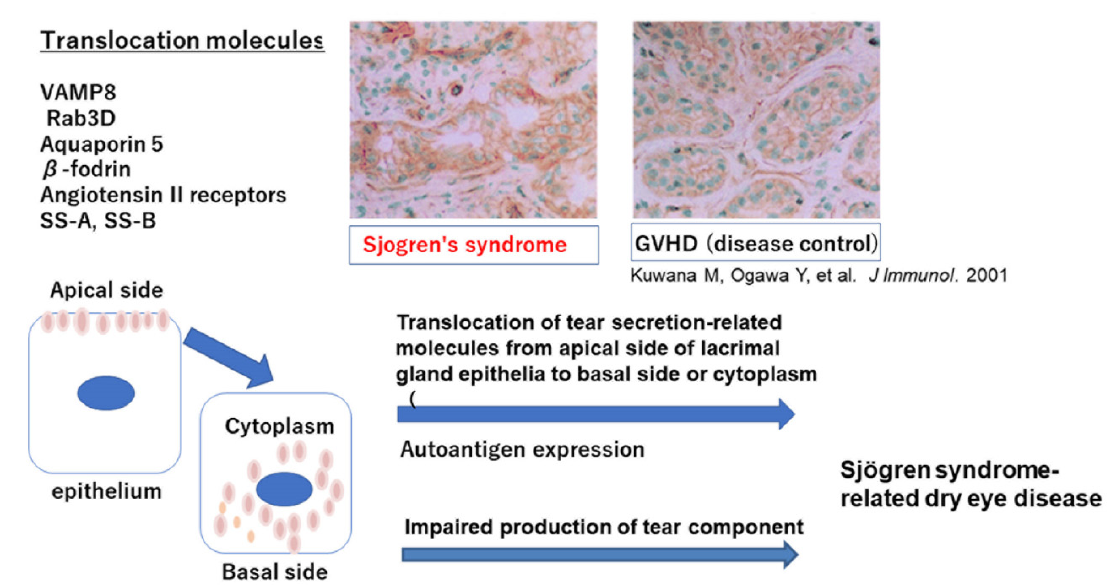
Figure 1. Translocation of tear secretion-related molecules from apical membrane to cytoplasma or basal side. β -fodrin, a membrane skeleton protein associated with ion channels and pumps, was